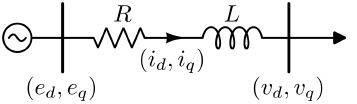
Figure 1. The single-phase schematic of a simple power system made up of an infinite bus, a line, and a